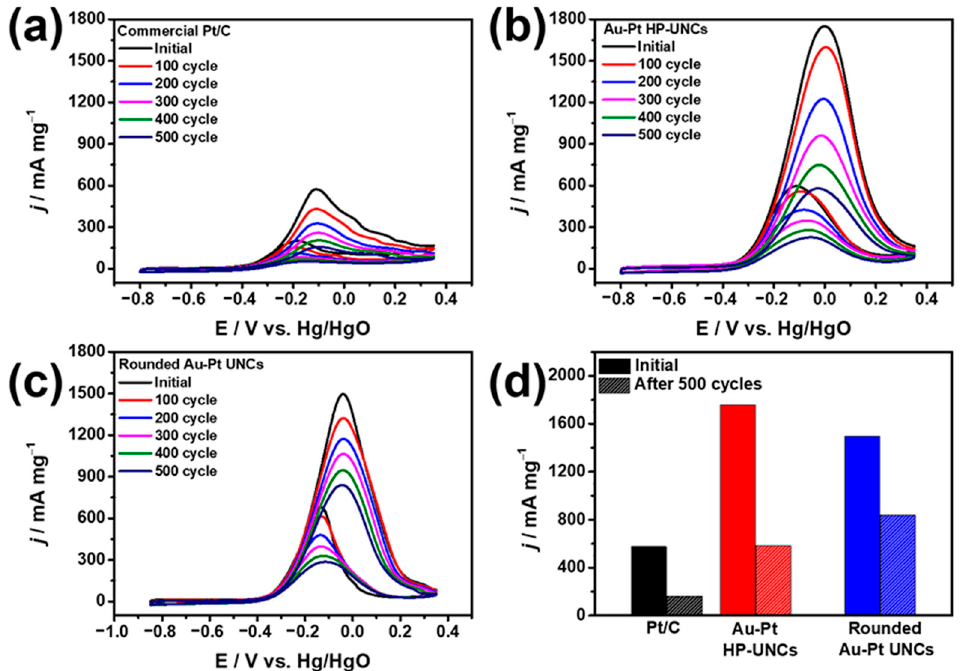
Figure 9. CVs obtained before and after MOR cycles for, ( a ) commercial Pt/C, ( b ) Au–Pt HP-UNCs, and ( c ) rounded Au–Pt UNCs in 0.1 M KOH/0.5 methanol at a scan rate of 50 mV s − 1 . Electrocatalytic stabilities of different catalysts in the ( d ) MOR.